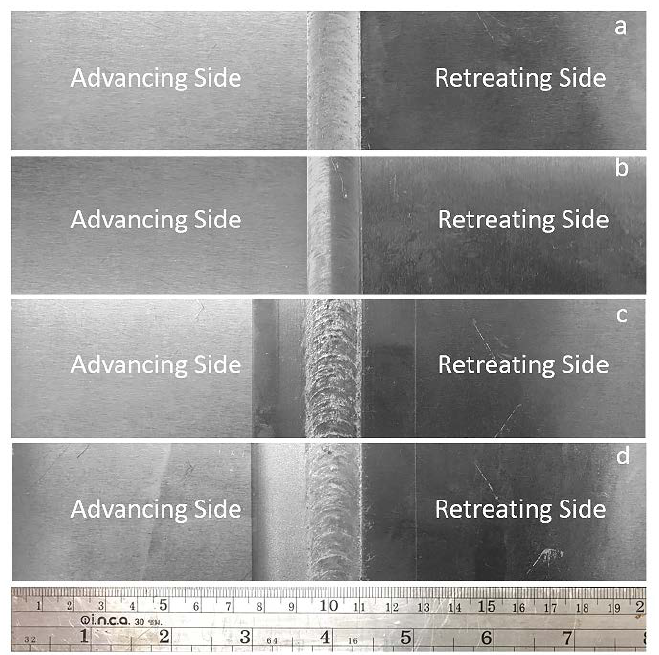
Figure 6. Photographs of the workpieces: ( a ) FSW; ( b ) FSW-PWHT; ( c ) FSW-DR; ( d ) FSW-PWHT-DR.